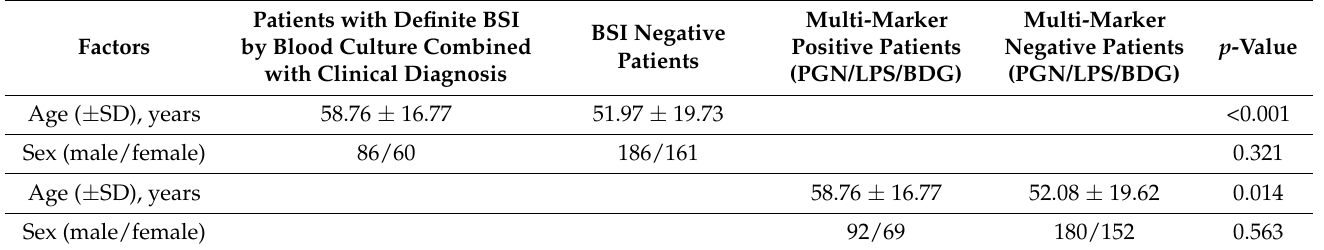
Table 1. The age and sex of the